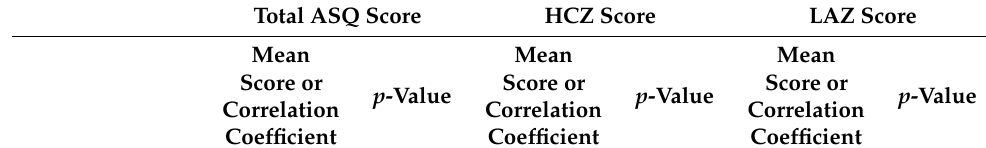
Table A6. Bivariate associations of ASQ, HCZ, and LAZ with ASF